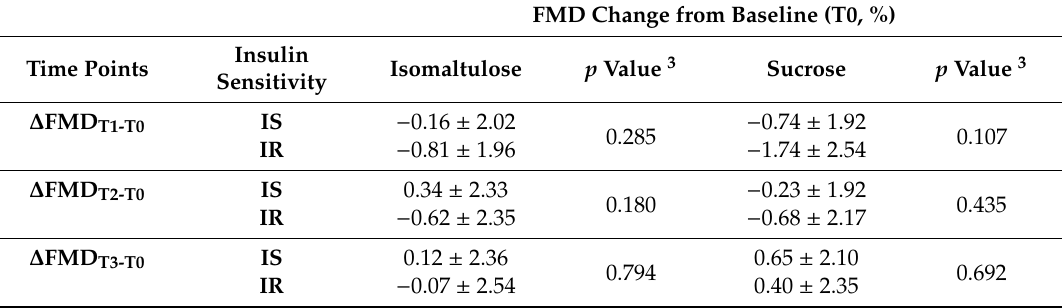
Table 2. Change in flow-mediated dilation from baseline in the subjects classified as insulin-sensitive and insulin-resistant according to HOMA index 1,2